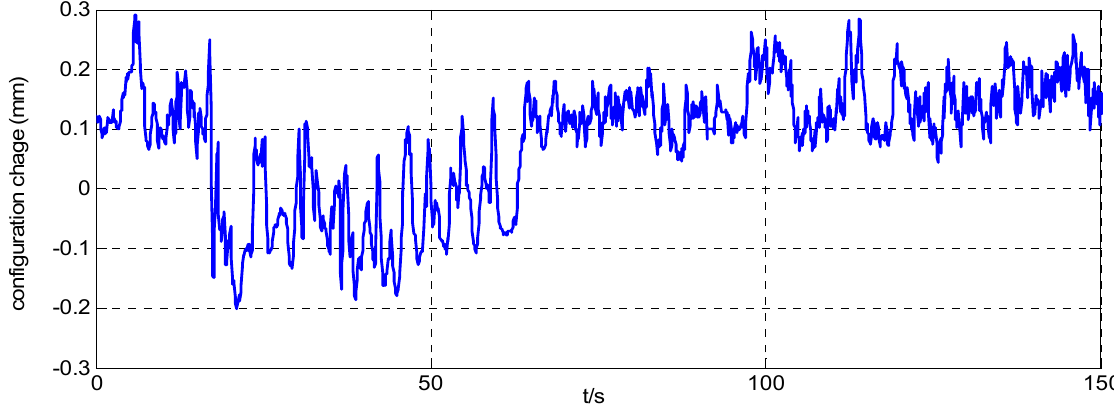
. Figure 15. Velocity along the x-axis of the simulator when